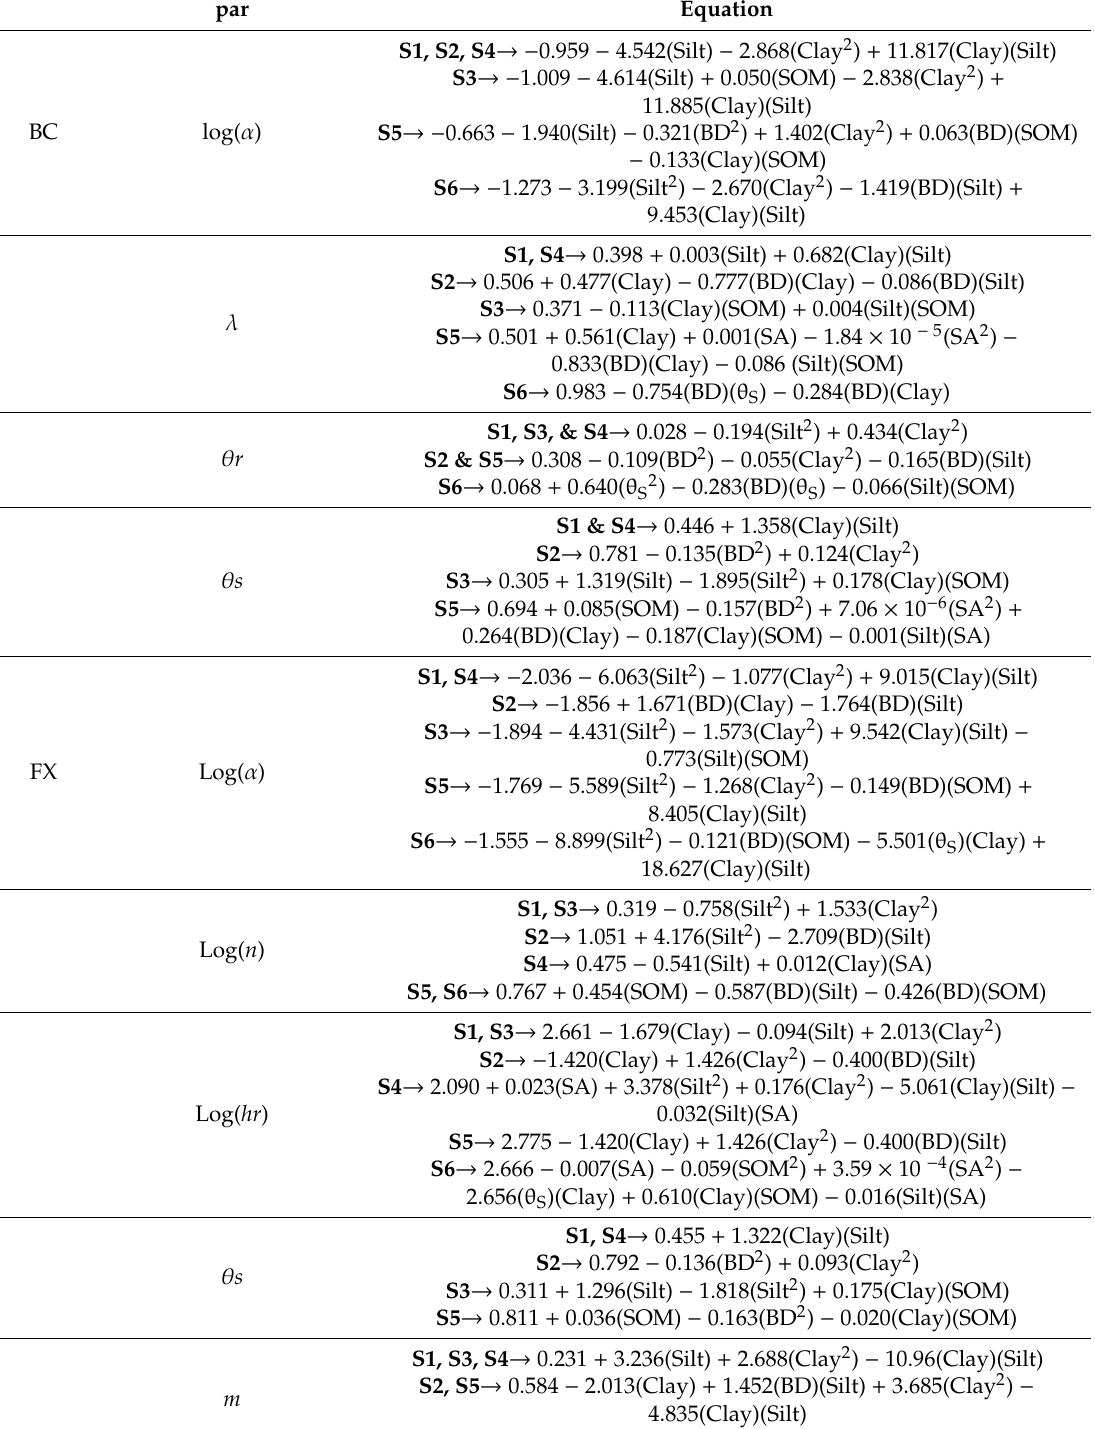
Table A1. List of regression equations (parametric PTFs) for estimating the parameters of the selected soil water retention models for the six modeling scenarios, S1–S6 (bold